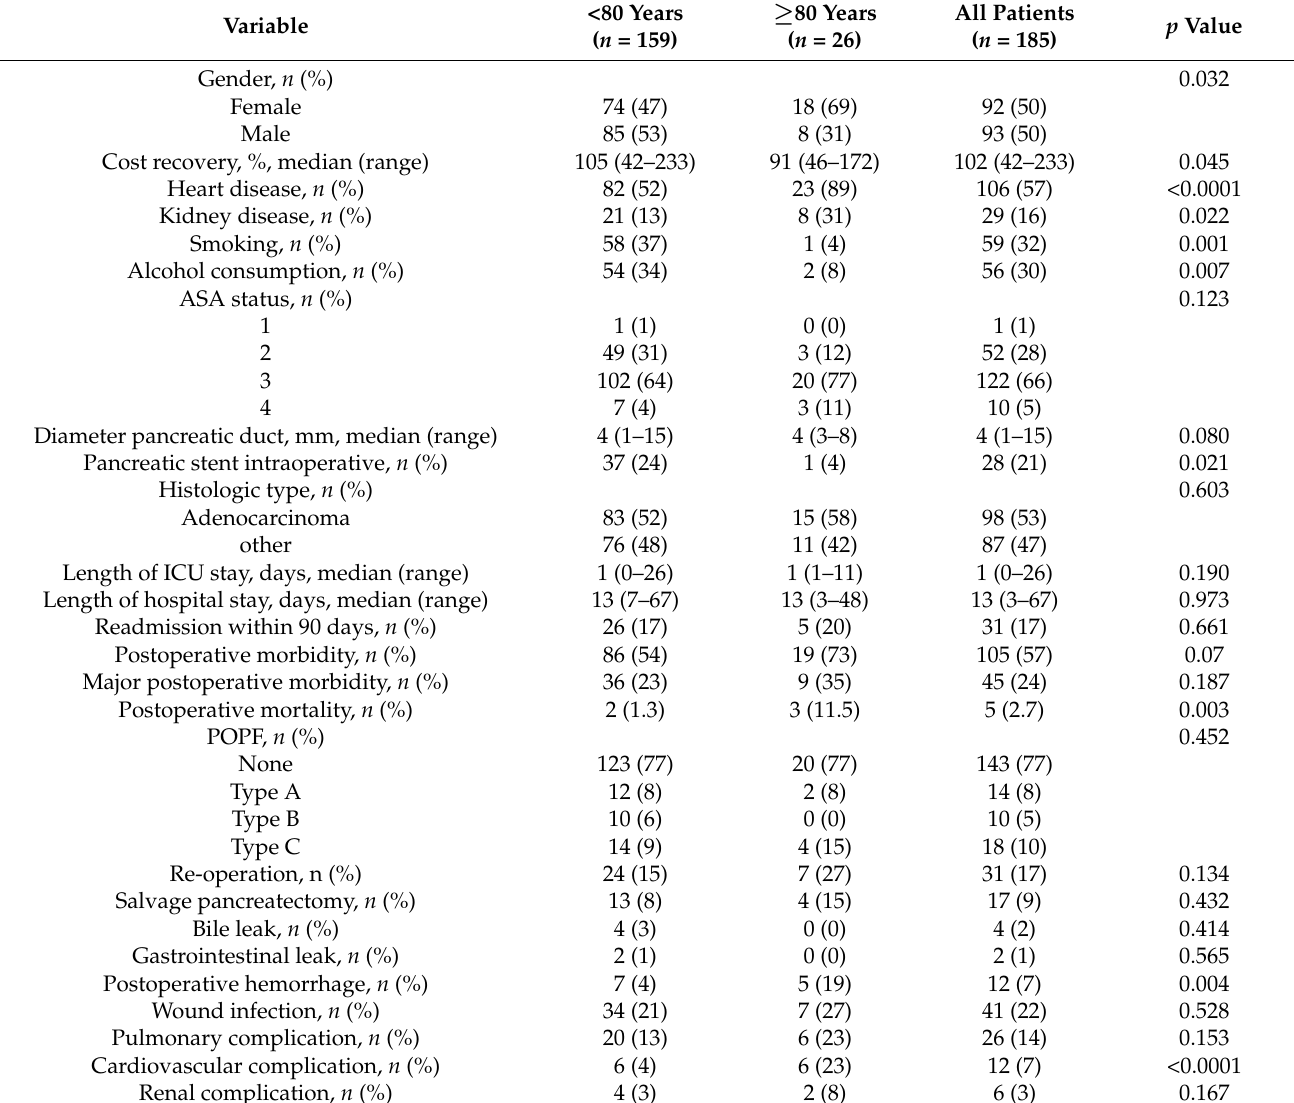
Table 2. Comparison of clinicopathological characteristics of 185 patients undergoing pancreatoduodenectomy according to patient